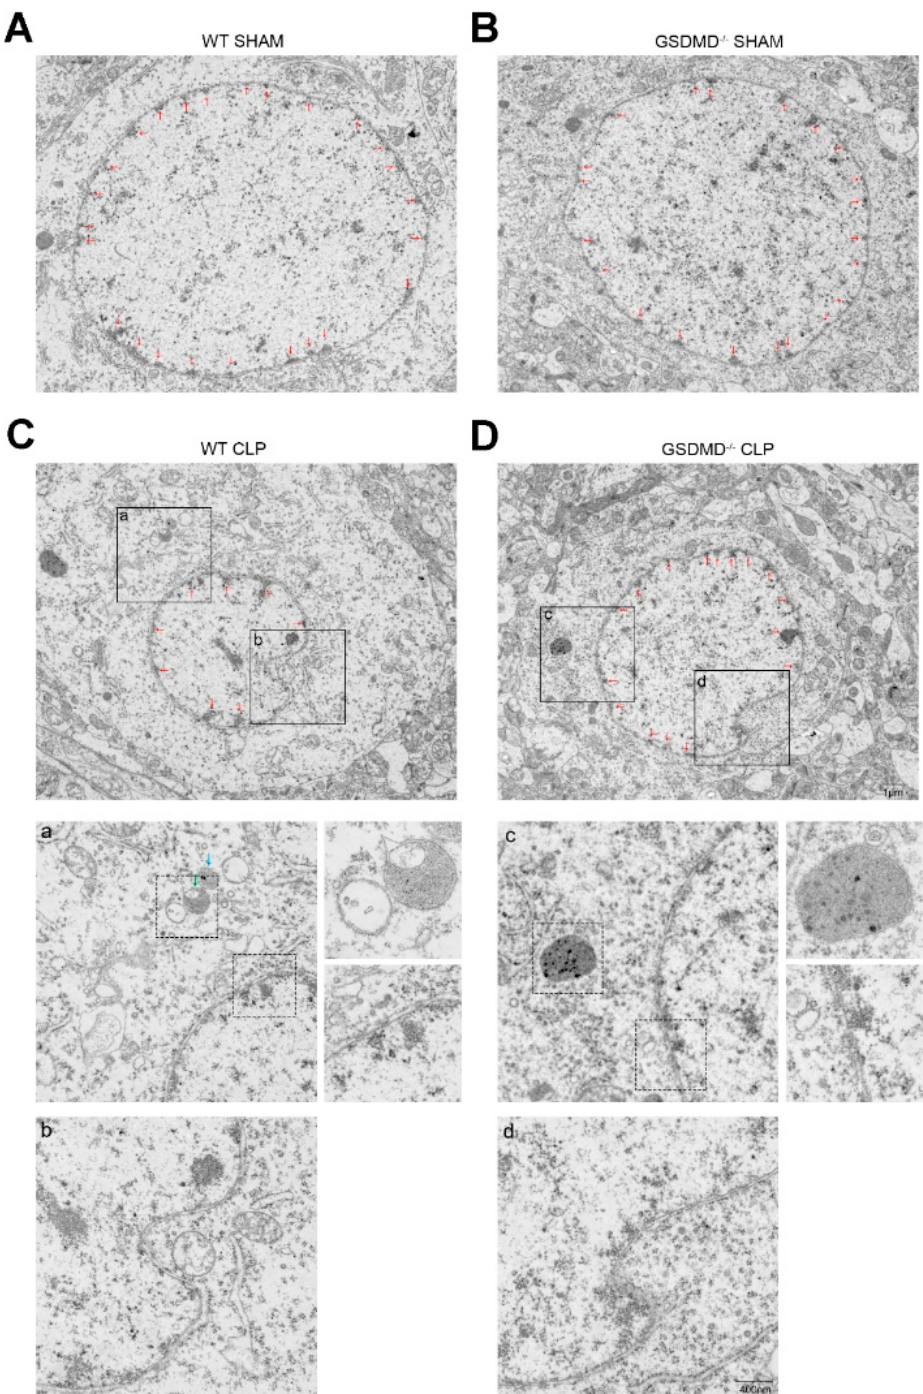
Figure 2. The absence of GSDMD reverses nuclear autophagy in the brain of septic mice. ( A − D ) Three days after sepsis onset, representative images of TEM of the nucleus of the wild- type sham group, GSDMD − / − sham group, wild-type CLP group, and GSDMD − / − CLP group, respectively. Scale bar: 1 µ m. ( a − d ) Representative images of autophagosomes, autolysosomes, and lysosomes. Interruptions of continuity of double neural nuclear membrane (bottom right of diagram ( a , c )) and nuclear membrane collapse in wild-type CLP group and GSDMD − / − CLP group. Scale bar: 400